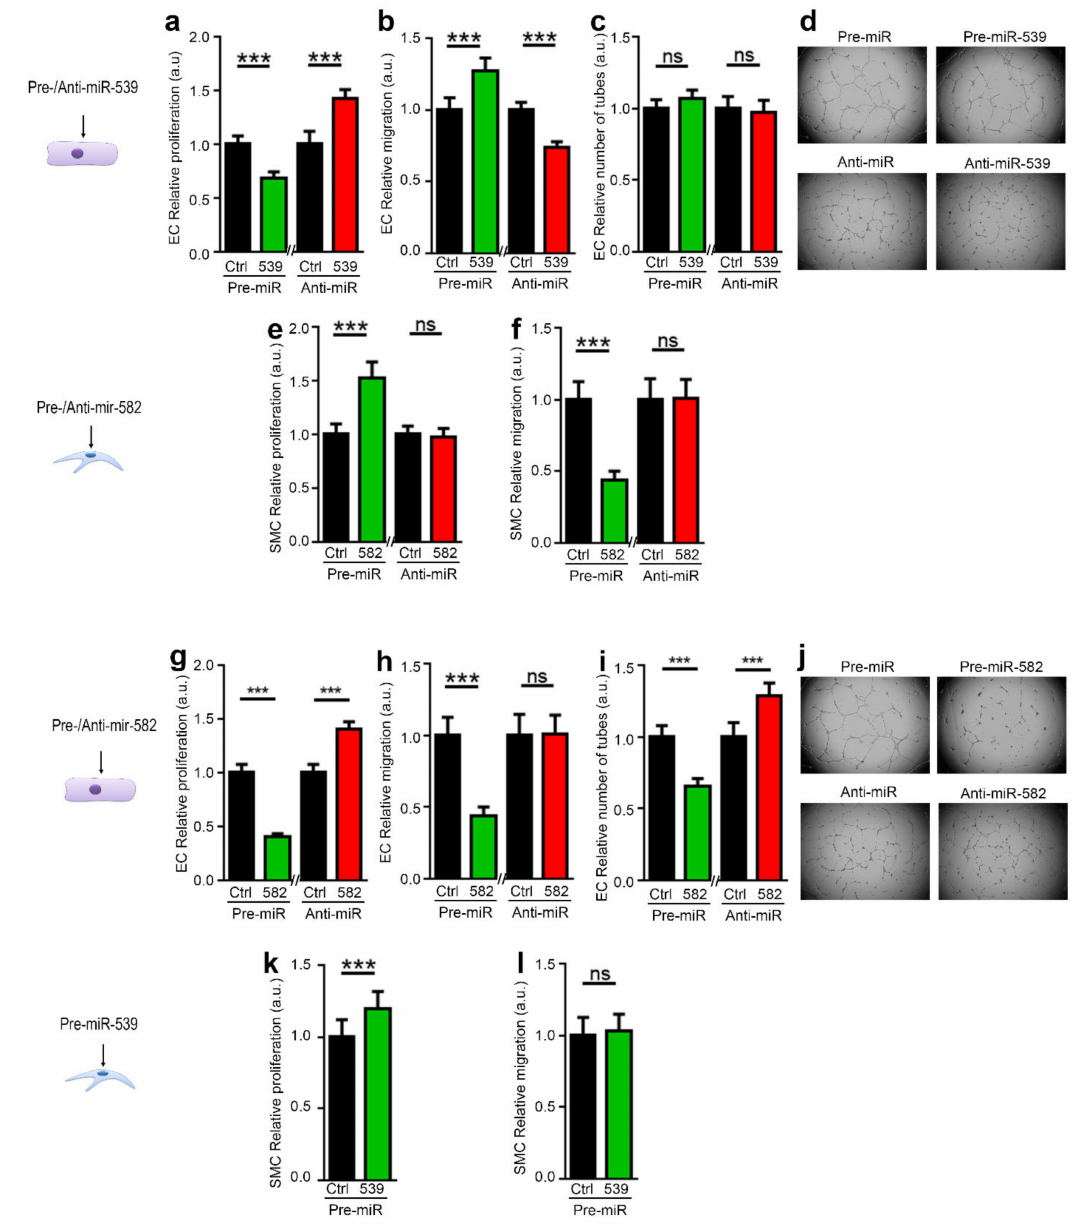
Figure 2. miR-539 and miR-582 modulate EC and SMC functions in vitro. ECs were transfected with pre-miR-539 or a pre-miR-Control or with an anti-miR-control or an anti-miR-539 ( a – d ). SMCs ( e , f ) or ECs ( g – j ) were transfected with pre-miR-582 or a pre-miR-control or with an anti-miR-control or an anti-miR-582. ( k , l ) SMCs were transfected with pre-miR-539 or a pre-miR-control. Cells were then used in the following bioassays: ( a , e , g , k ) proliferation assay, ( b , h ) migration wound-healing assay of ECs, ( l , f ) migration of SMCs in boyden chamber assay, and ( c , d , i , j ) tubulogenesis assay of ECs. Right: representative images from d and j are shown. All data are the mean ± SD ( n = 3 independent experiments). *** p < 0.001 vs. the respective